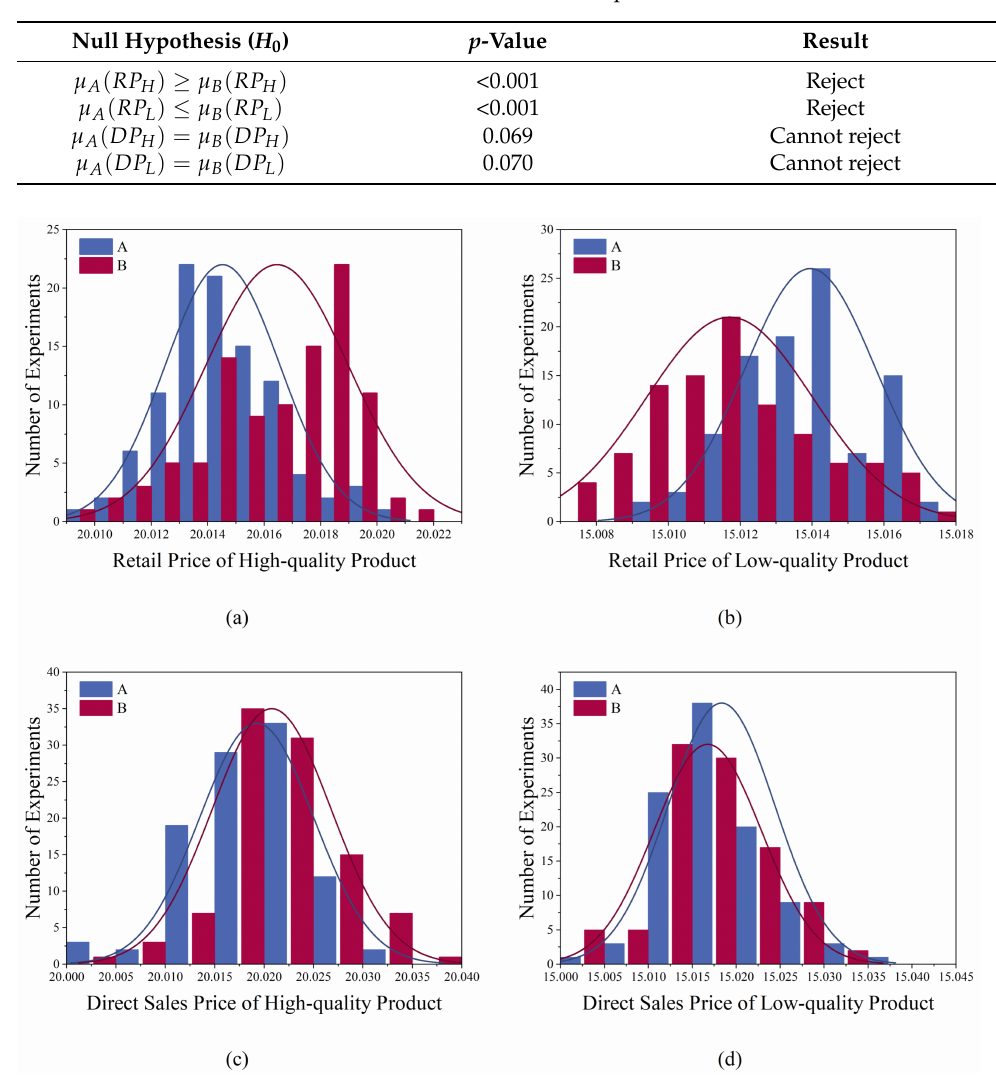
Figure 6. Prices in A and B of: ( a ) high-quality product in retail channel; ( b ) low-quality product in retail channel; ( c ) high-quality product in the direct sales channel; ( d ) low-quality product in the direct sales channel. ( t = 100). Table 4. Statistical test results for Scenario A and Scenario B prices.